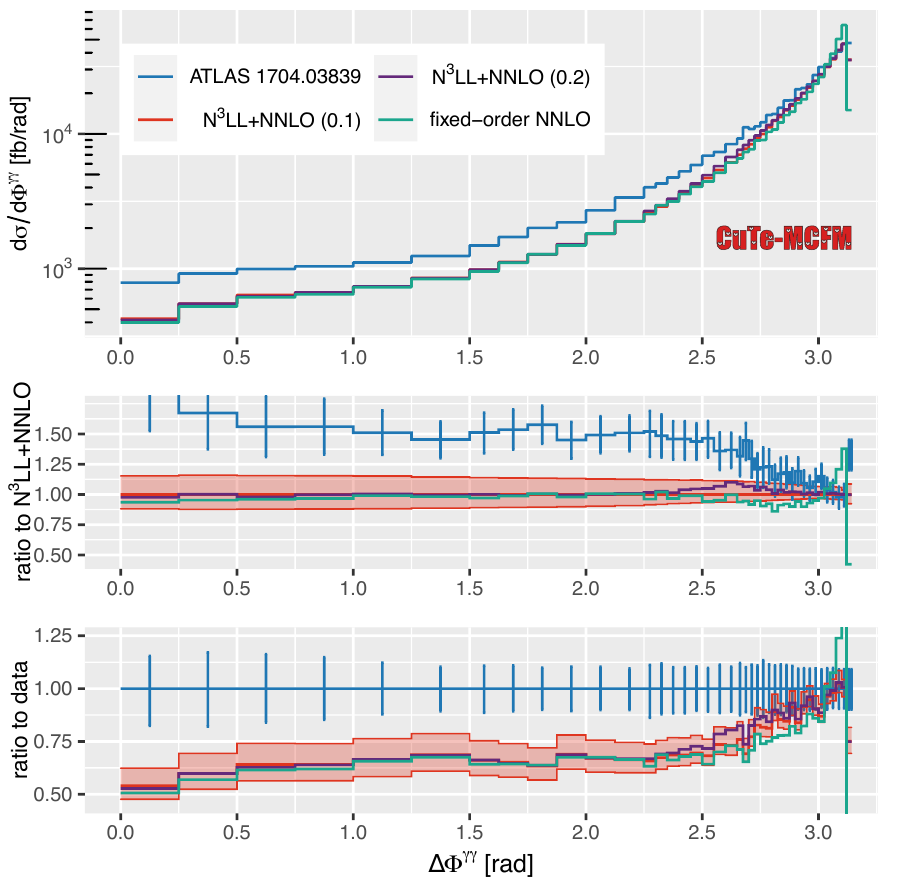
Figure 20. Comparison of the ATLAS measurement of the diphoton ∆ φ at 8 TeV with predictions at N 3 LL+NNLO including uncertainties associated with scale variation. The labels 0 . 1 and 0 . 2 in the plots refer to the value of x max